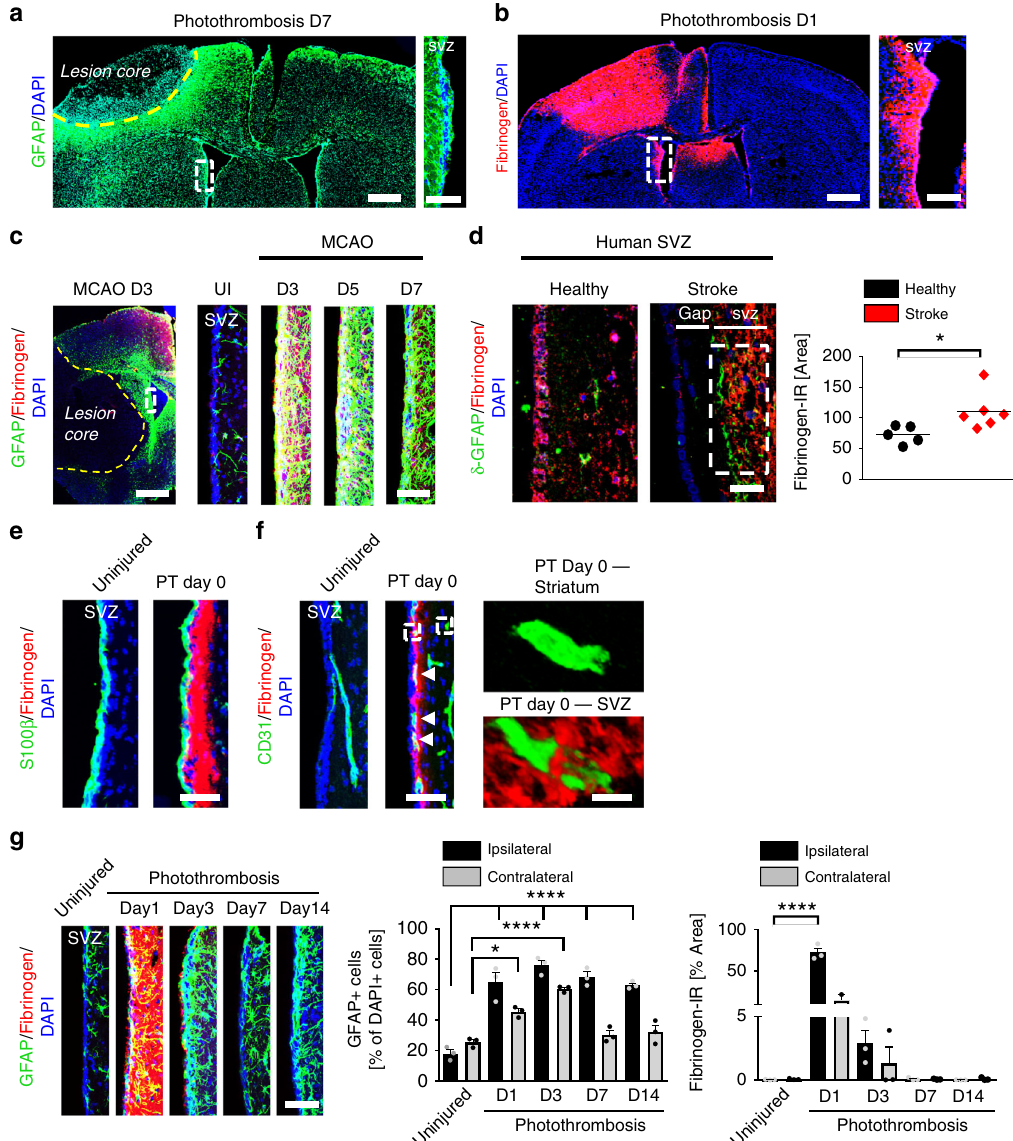
Fig. 1 Fibrinogen deposition in the SVZ after cortical injury. a GFAP immunostaining (green) around the lesion core (indicated by yellow dotted line) and in the SVZ. White box indicating enlargement of SVZ showing GFAP expression in the adult SVZ 7 days after PT (right) ( n = 4 mice). Scale bars, 369 μ m, left and 57 µ m, enlargement. b Fibrinogen immunostaining (red) in the lesion core and in the SVZ 1 day after PT. White box indicating enlargement of SVZ showing fi brinogen deposition in the SVZ 1 day after PT (right) ( n = 4 mice). Scale bars, 428 μ m, left and 120 µ m, enlargement. c GFAP (green) and fi brinogen (red) immunostainings in the lesion core (left) and in the SVZ (right) 3, 5 and 7 days after stroke (MCAO). White box indicating enlargement of SVZ showing increased GFAP expression colocalizing with fi brinogen (red) deposition in the SVZ 3 days after stroke. Scale bars, 543 μ m, left and 50 µ m, right ( n = 3 mice). d δ -GFAP (green) and fi brinogen (red) immunostainings in the SVZ of patients after stroke compared to healthy controls. White box indicating quanti fi cation area. Scale bar, 25 μ m. Quanti fi cation of fi brinogen immunoreactivity in the SVZ per area ( n = 5 (healthy control), n = 6 (stroke patients, mean ± s.e.m., unpaired Student ’ s t -test, * P < 0.05). e Representative images of S100 β + ependymal cells (green) lining the lateral ventricle and adjacent fi brinogen (red) in the SVZ 5 h after PT (PT Day 0). Scale bar, 40 μ m. f CD31 + endothelial cells (green) and fi brinogen (red) in the SVZ and striatum 5 h after PT (PT Day 0). White boxes indicating enlargement of fi brinogen deposition around blood vessels in SVZ (right, bottom) compared to no fi brinogen deposition around blood vessels in the striatum (right, top) after PT. Scale bars, 40 μ m, left and 95 µ m, enlargement. g GFAP + astrocytes (green) and fi brinogen (red) in the ipsilateral SVZ at different days after PT and uninjured mice. Scale bar, 57 μ m. Quanti fi cation of GFAP + cells and fi brinogen immunoreactivity in the SVZ per area ( n = 3 mice, mean ± s.e.m., one-way ANOVA and Bonferroni ’ s multiple comparisons test, * P < 0.05, **** P < 0.0001). SVZ subventricular stem cells in culture (Supplementary Fig. 3b) with the intrinsic adult SVZ-derived and hippocampal-derived NSPC differentia- ability to form neurospheres and to differentiate into neurons, tion into astrocytes, revealed by increased abundance of GFAP + , astrocytes and oligodendrocytes upon growth factor withdrawal Aldh1l1 + , and Aqp4 + cells and an increase in GFAP , Aqp4 , and and adherent culture conditions 24 . Extracellular signals drive Aldoc mRNA and protein expressed by astrocytes (Fig. 2a – e ; NSPCs toward a glial or a neuronal fate 25 . Fibrinogen induced Supplementary Fig. 3c). Fibrinogen treatment of SVZ- and